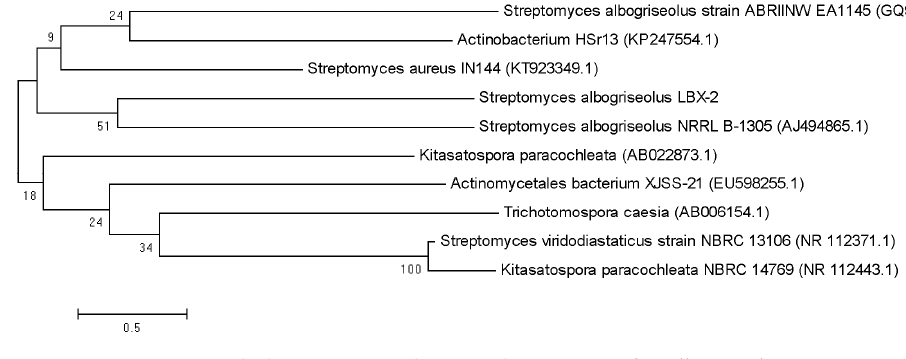
Figure 7. Phylogenetic tree showing the position of S. albogriseolus LBX-2.